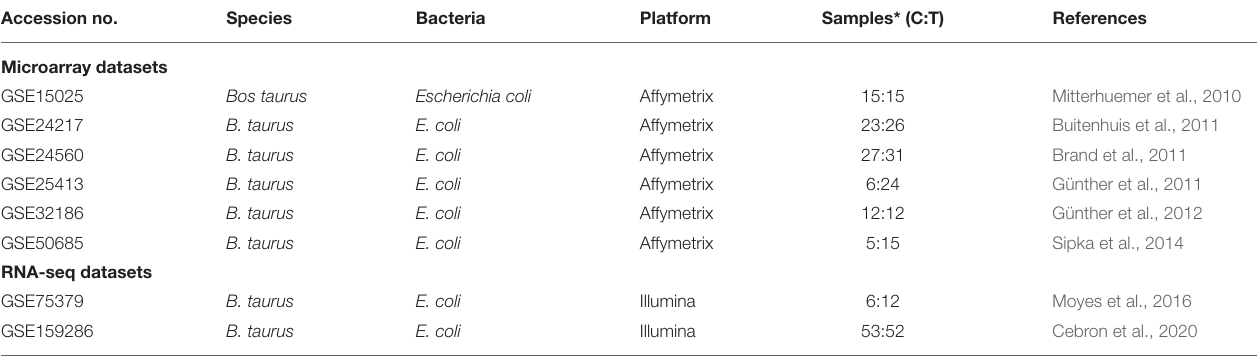
TABLE 1 | Selected microarray and RNA-seq datasets for systems biology analysis of mastitis disease. Accession no.